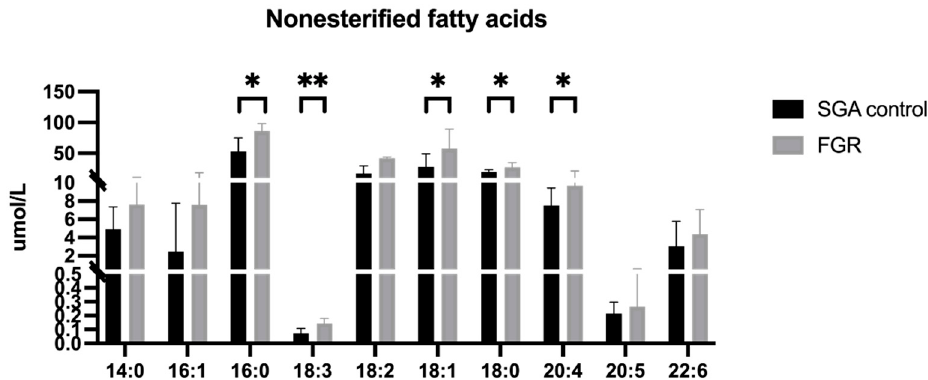
Figure 3. Non-esterified fatty acid concentrations (µmol/L) in umbilical vein plasma. SGA control (n = 12) and FGR (n = 7) umbilical vein plasma concentrations of individual non-esterified fatty acids, expressed as median ± IQR in µmol/L. * p < 0.05; ** p < 0.01. Abbreviations: SGA, small for gestational age; FGR, fetal growth restriction; IQR, interquartile range.